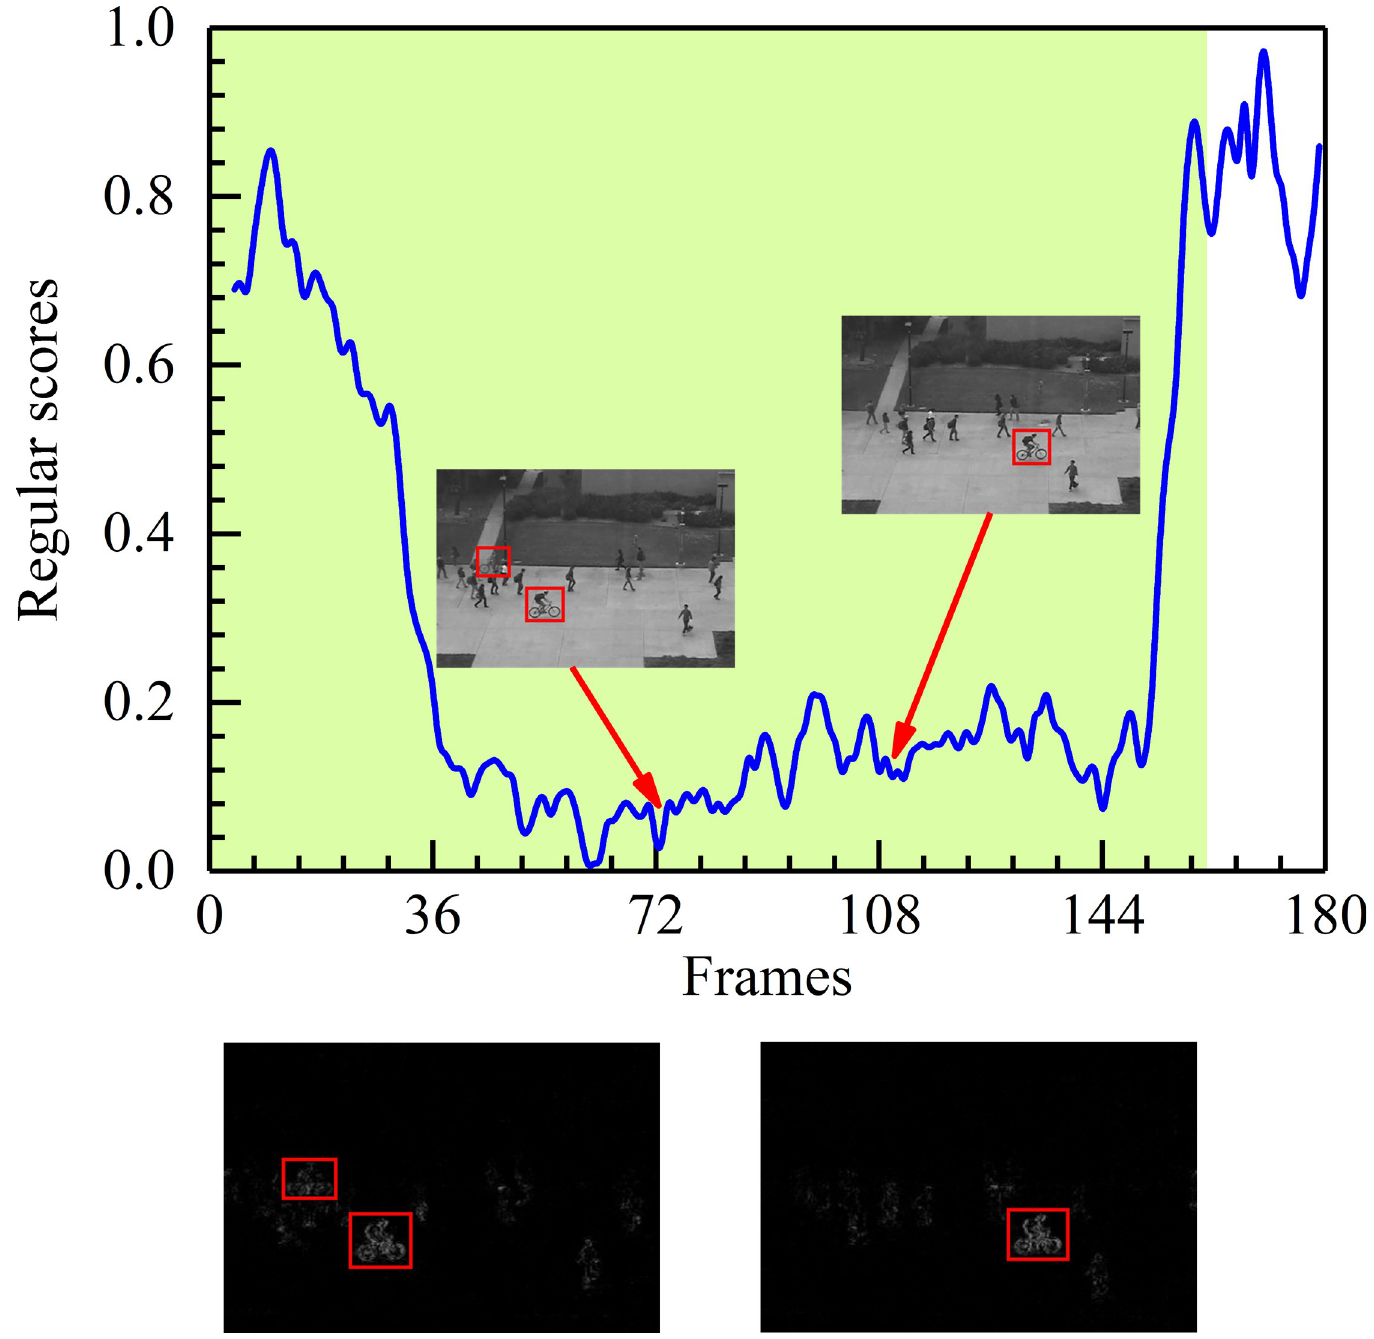
Fig 9. Frame-level evaluation results on the 6th test video of UCSD Ped2. (a) Relationship between the test video frames and the regular score. (b) Difference between the ground truth and the corresponding generated frame.